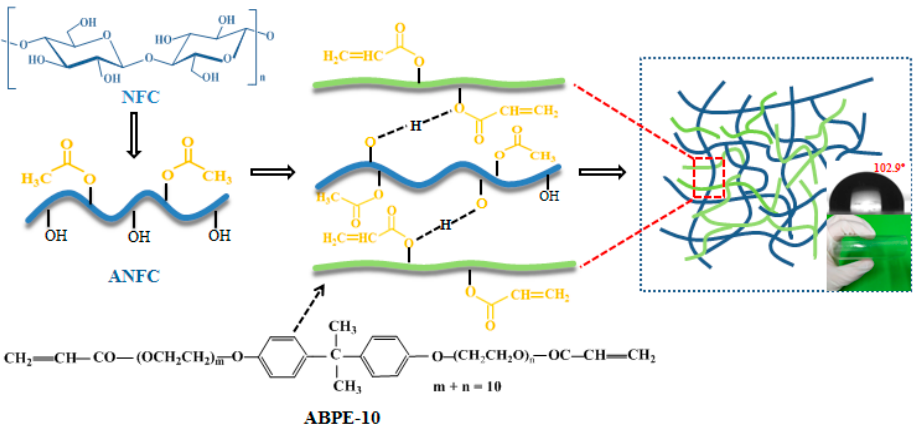
Figure 1. Interpenetrating polymer network (IPN) of acetylated nanofibrillated cellulose (ANFC)/acrylic resin ABPE-10 composite film.